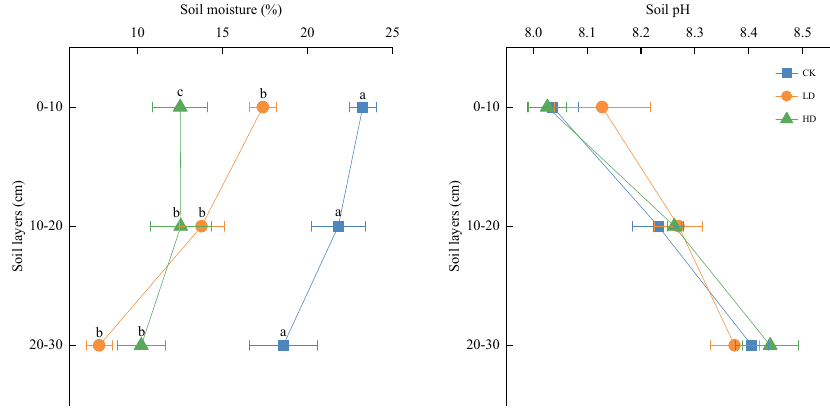
Figure 5. Soil moisture and pH of P. kansuensis patches in different densities. Various alphabetical characters depict significant differences among diverse density patches in the same soil layer ( p < 0.05). The same applies to Figure 6.